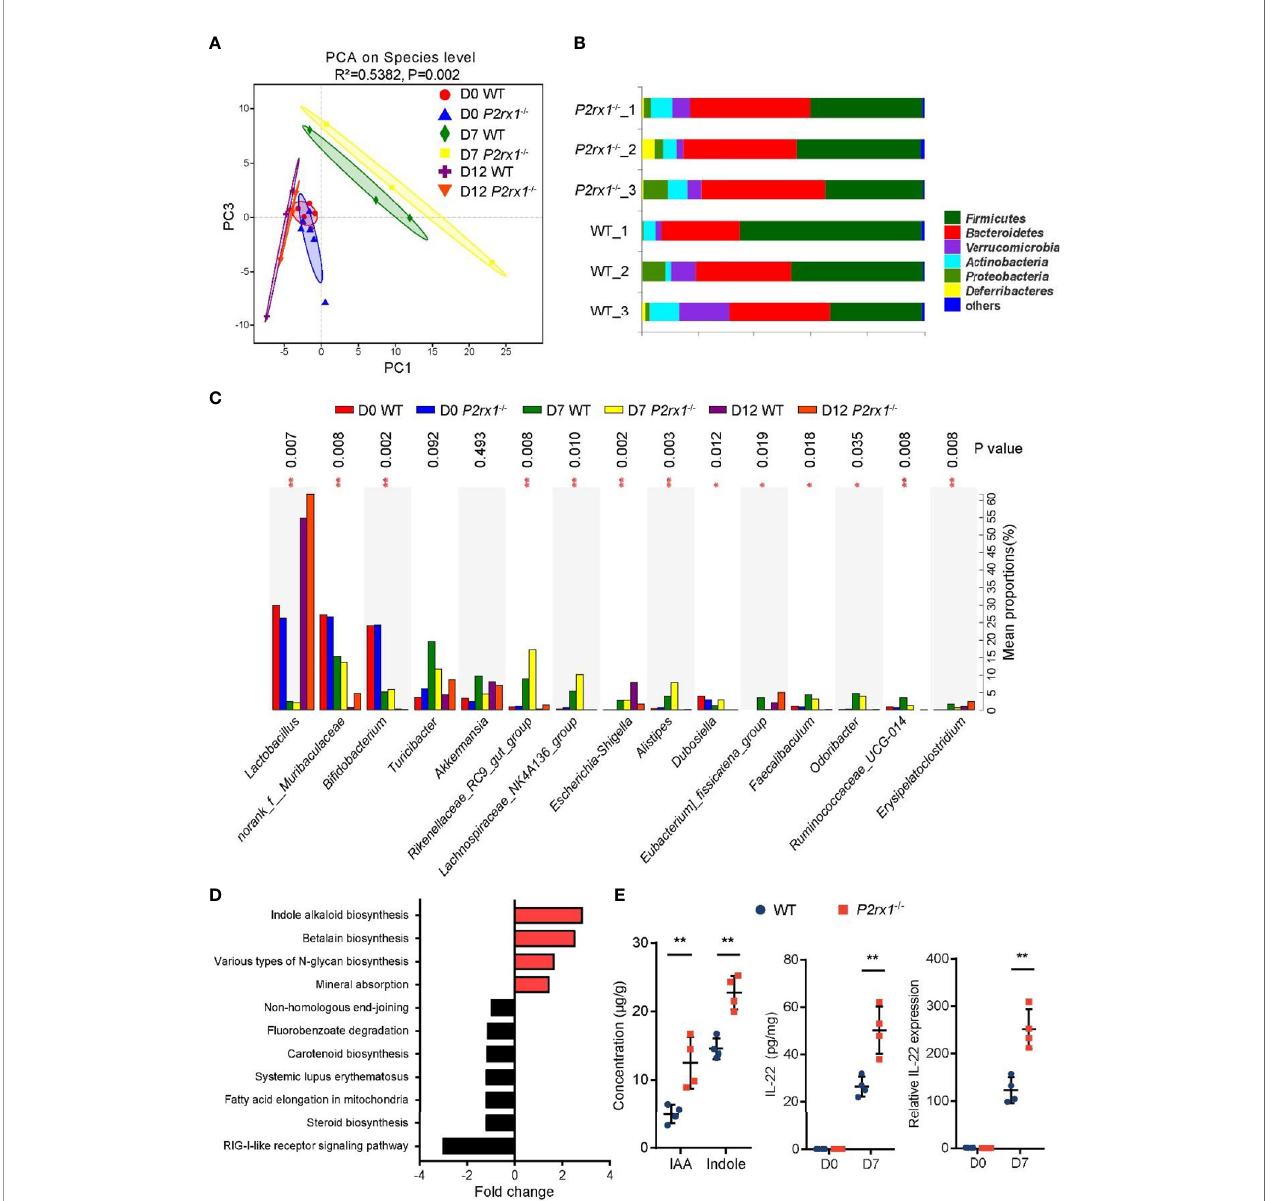
FIGURE 4 | Intestinal microbiota is altered in DSS-treated P2rx1 − / − mice. (A) WT and P2rx1 − / − mice were treated with 2% DSS for 7 days. At days 0, 7 and 12, fecal microbiota was quanti fi ed using 16S rDNA sequencing. Principal component analysis (PCA) was performed based on the operational taxonomic units (OTUs) composition (n = 6 for D0 WT and P2rx1 − / − groups, n = 3 for the rest groups). (B) Relative abundance of bacterial phylum in the fecal microbiota was analyzed. (C) Detailed comparison of bacterial genus in WT and P2rx1 − / − mice was performed. (D) Functional metagenomics prediction analysis based on the result of 16S rDNA gene sequencing using PICRUSt1 was performed. (E) Fecal indole-3-acetic acid (IAA) and indole at day 7 were detected. IL-22 mRNA and protein at day 0 and day 7 were determined (n = 4 per group). **P <